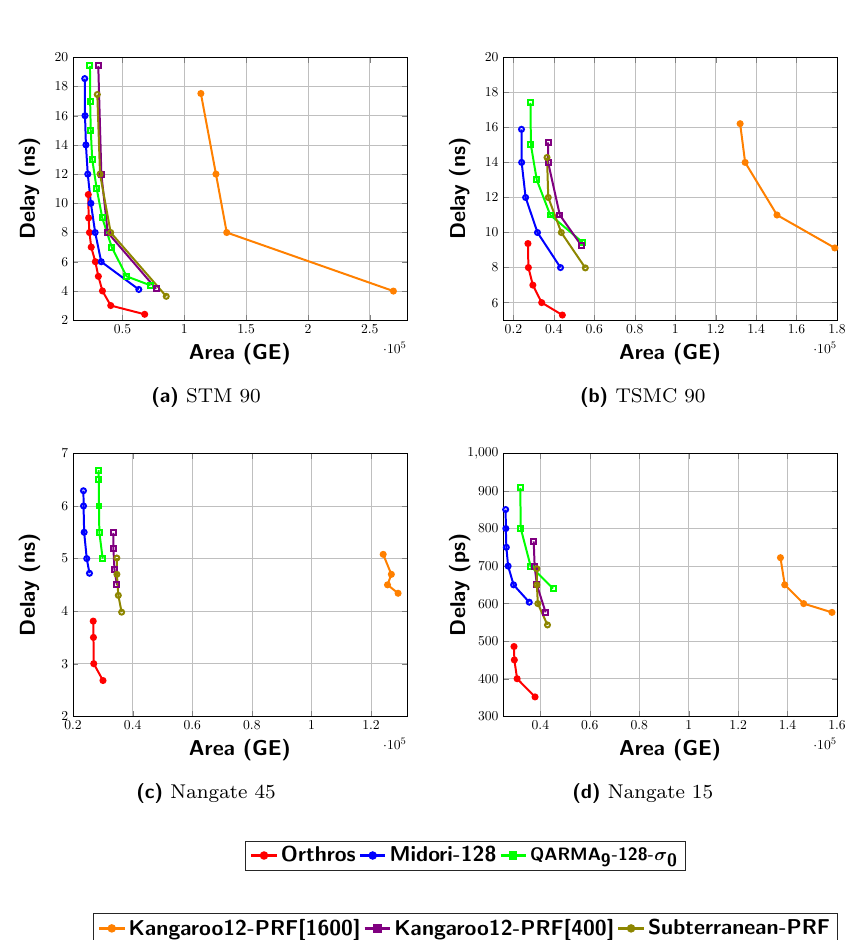
Figure 7: Delay vs Area